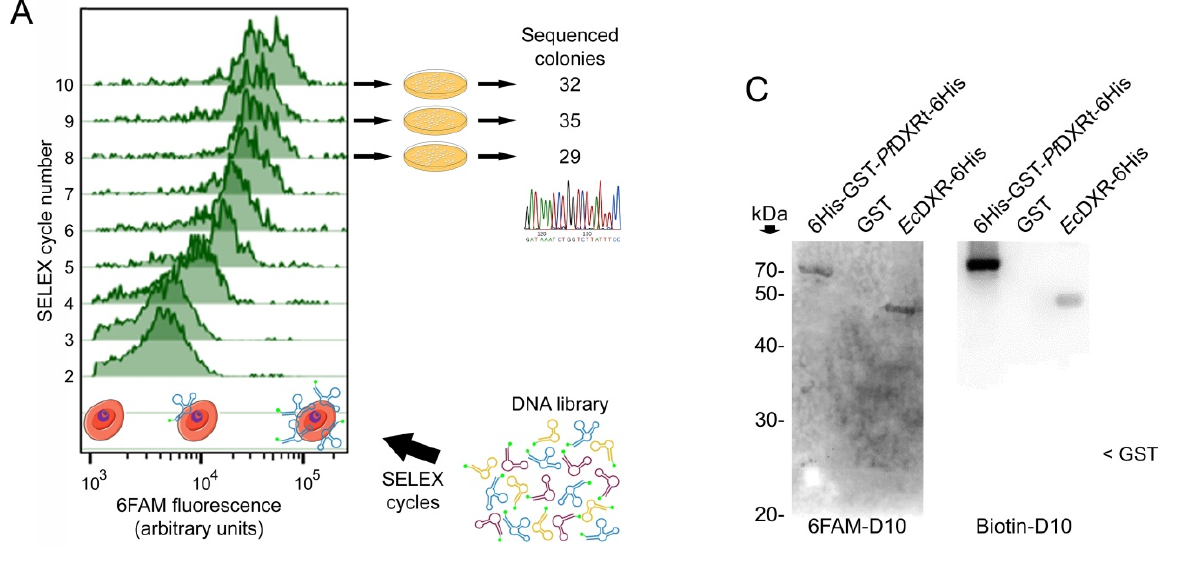
Figure 3. Selection of specific aptamers against Pf DXR. ( A ) Schematic rendering of the progressive selection of pRBC-binding 6FAM-labeled aptamers along the SELEX cycles 2 to 10. The enrichment in specific aptamers originally present in the randomly synthesized DNA library is reflected by an increase in the binding of the selected fluorescent oligonucleotides to pRBCs, which become permeable to aptamers after the fixation step prior to the flow cytometry analysis shown. ( B ) D10 sequence, showing in bold the PCR primer-binding regions. ( C ) Western blot analysis of D10 binding to 6His-GST- Pf DXRt-6His and Ec DXR-6His. The approximate electrophoretic mobility of free GST is indicated. Petri dish cartoon reproduced with permission (https://creativecommons.org/licenses/by-nc-nd/2.0/legalcode, accessed on 23 April 2021).